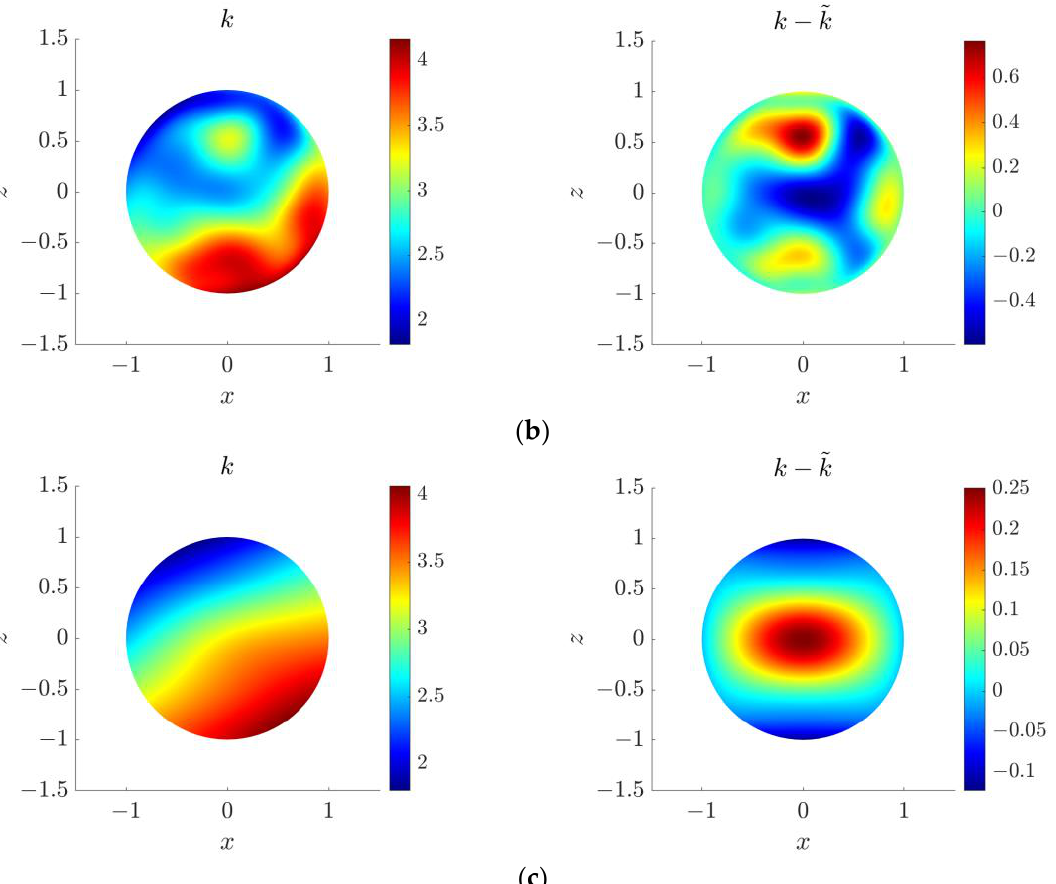
k for the 3D parameter identifica-